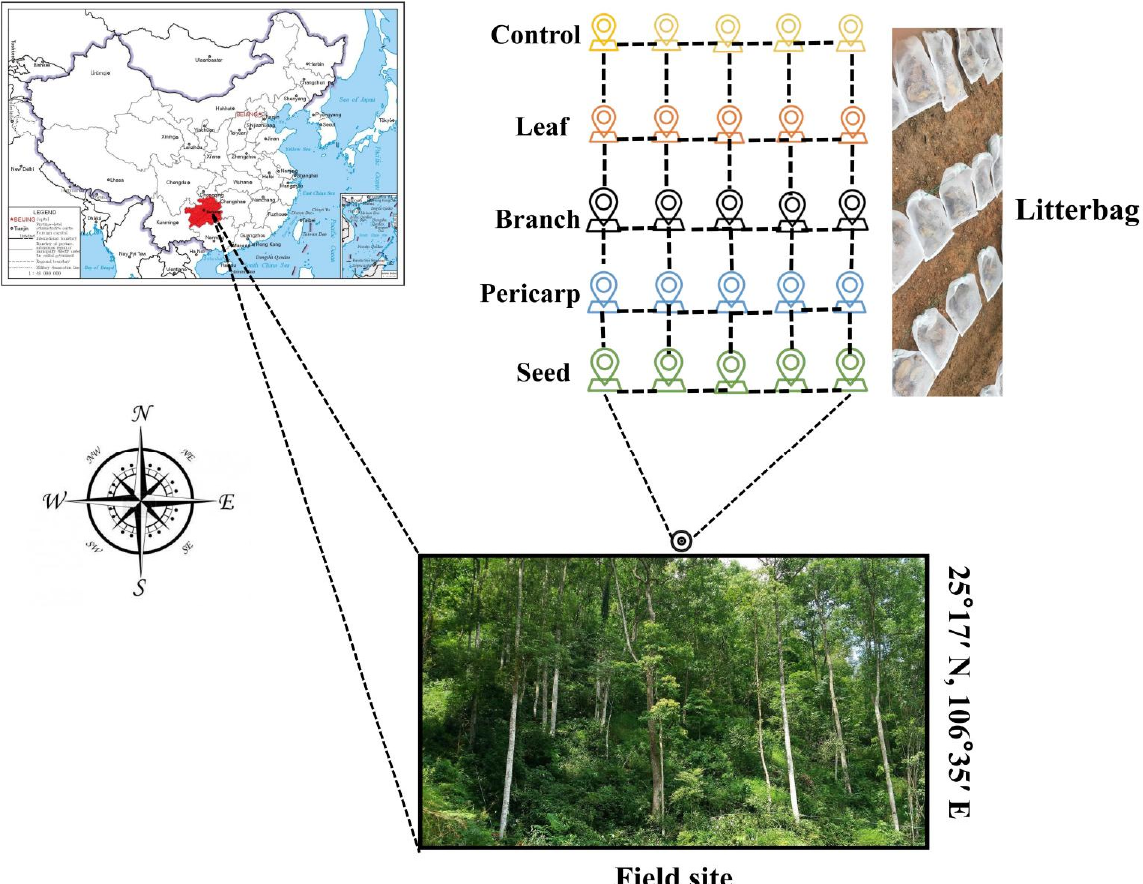
Figure 1. Distribution of the sampling plots and layout of the litter bags. The small legend represents litter bags placed along the sampling site.